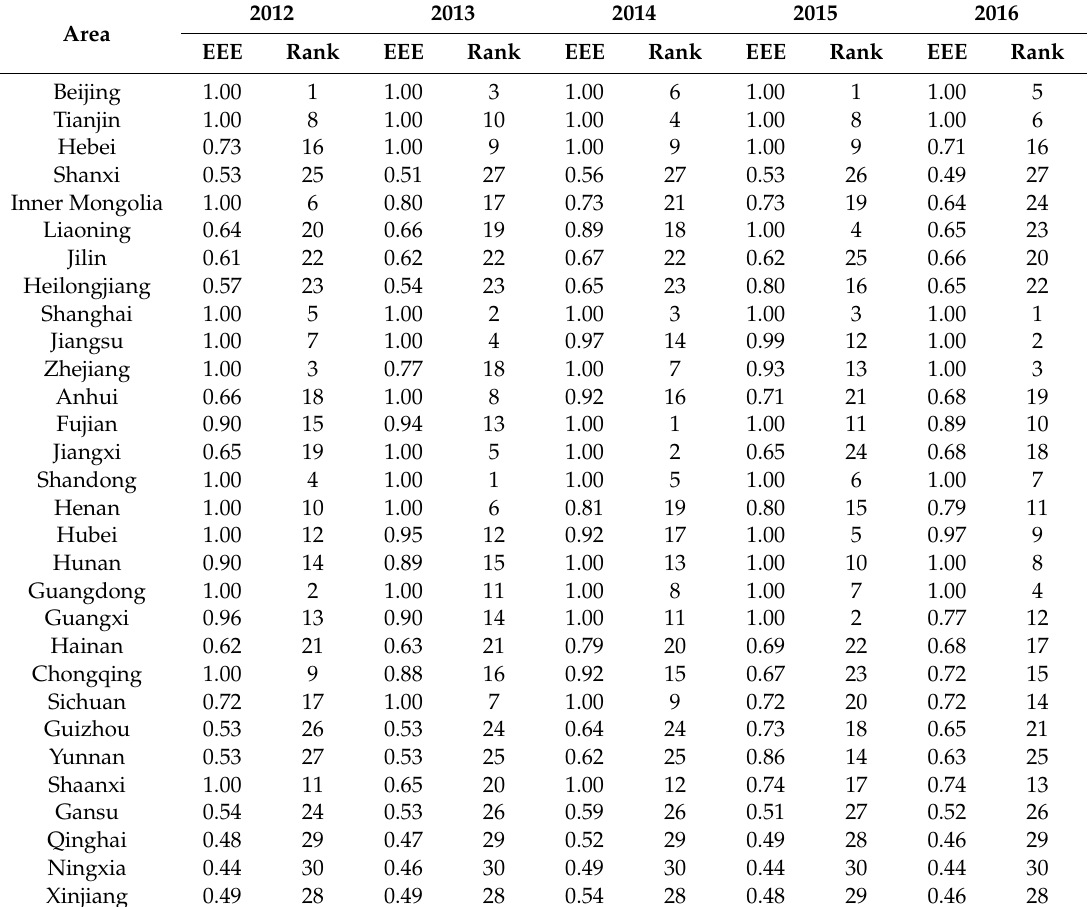
Table 5. Final EEE of 30 Chinese province-level areas from 2012 to